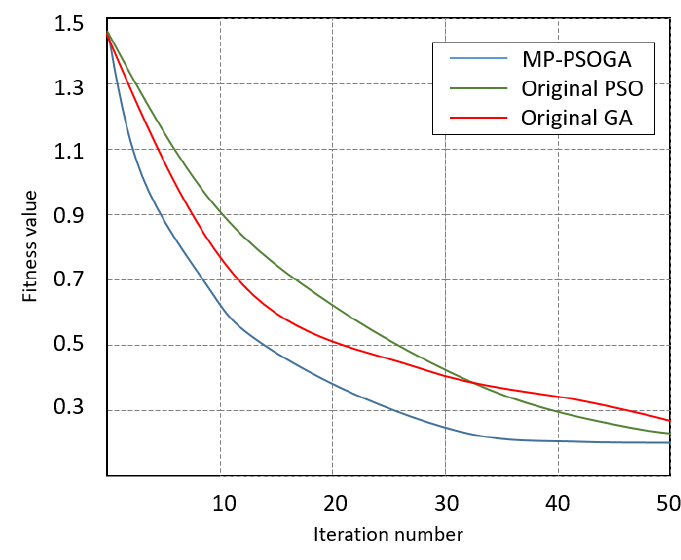
Figure 21. Comparison between MP-PSOGA, original PSO and GAs.